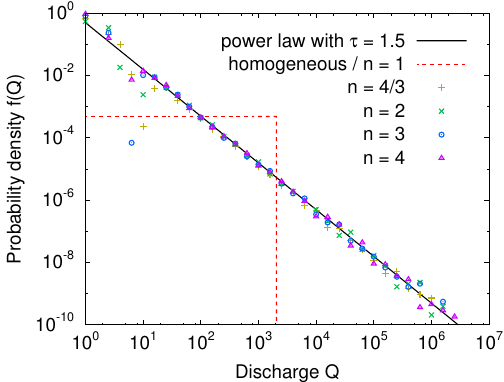
Figure 2. Probability density of the spring discharges of the flow patterns shown in Fig. 1 measured along the boundaries of the do- main. Discharges are scaled by assuming a unit recharge at each site, so that the discharge is the same as the number of sites in the re- spective catchment. The estimated discrete values were obtained by logarithmic binning with five bins per decade. The distributions for homogeneous porosity and for n = 1 are identical and correspond to straight flow lines towards the